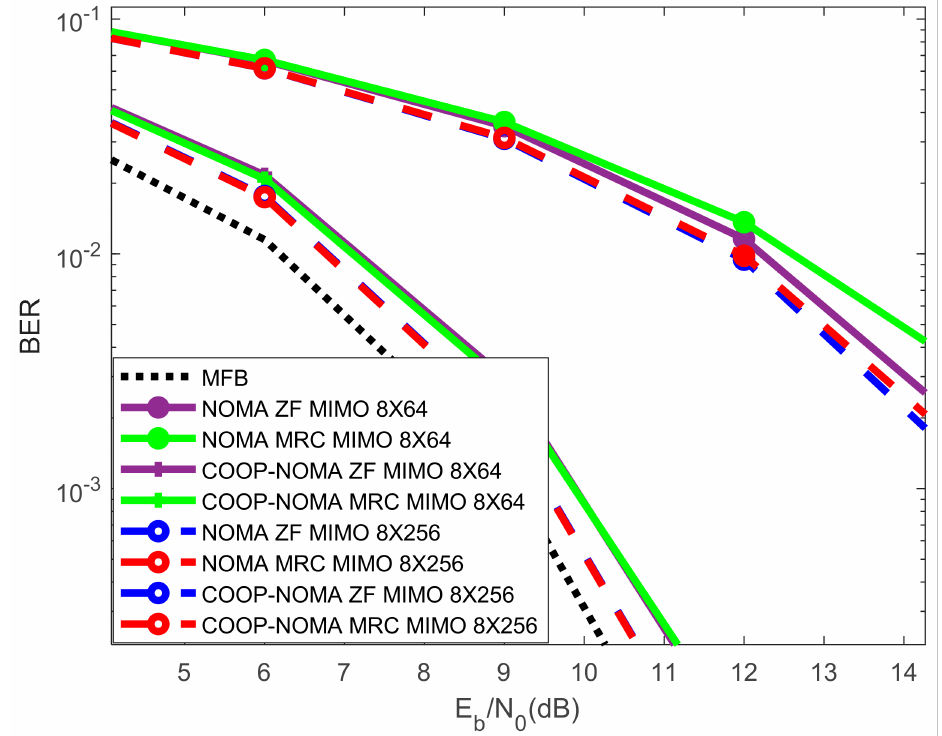
Figure 8. Results for 3 NOMA users with powers [1, 0.5, 2] with 8 × 64 versus 8 × 256 MIMO, with LDPC